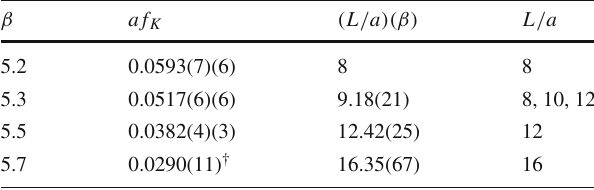
Table 3 Values of af K used to determine ( L / a )(β) such as to satisfy thecondition(4.2)forthegiven β .The χ SF simulationswereperformed at the neighbouring even integer L / a -values given in the last column